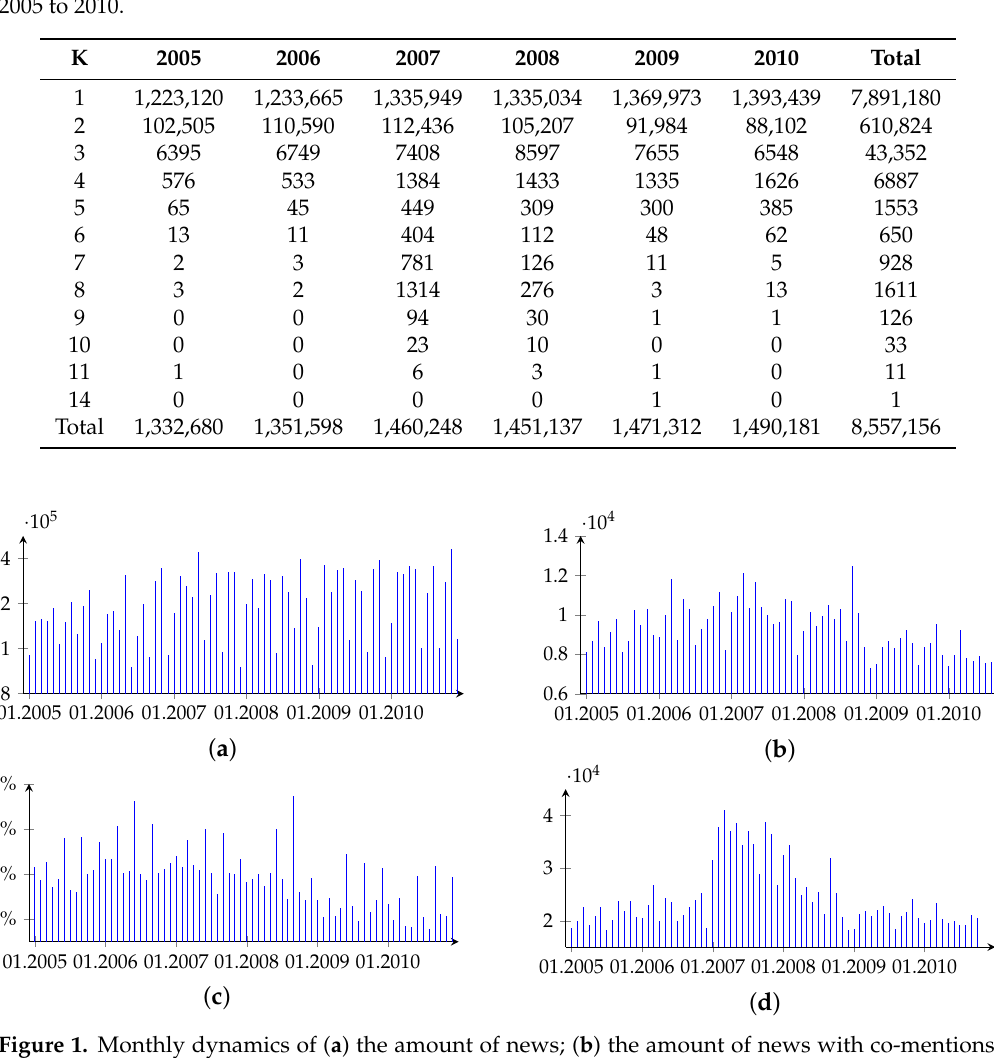
Table 4. The amount of news items mentioning a given number of companies ( K ) in each year from 2005 to 2010.